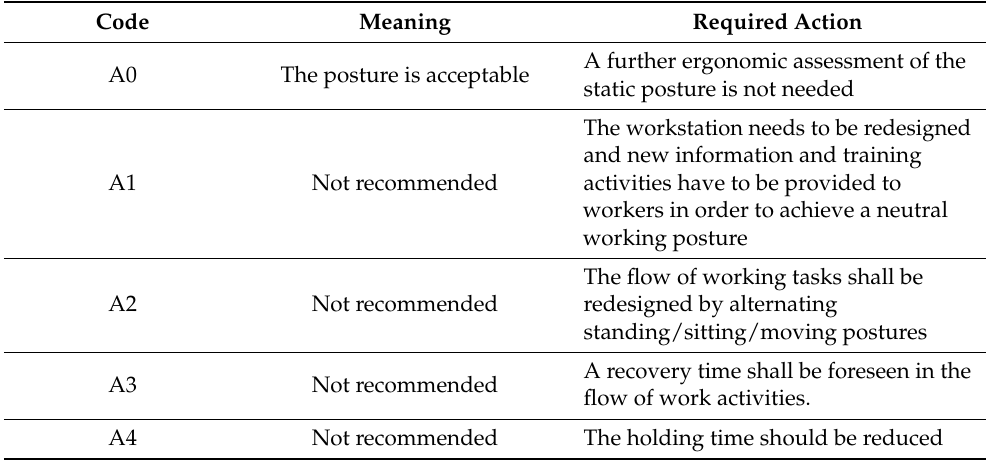
Table 1. Required actions for risk